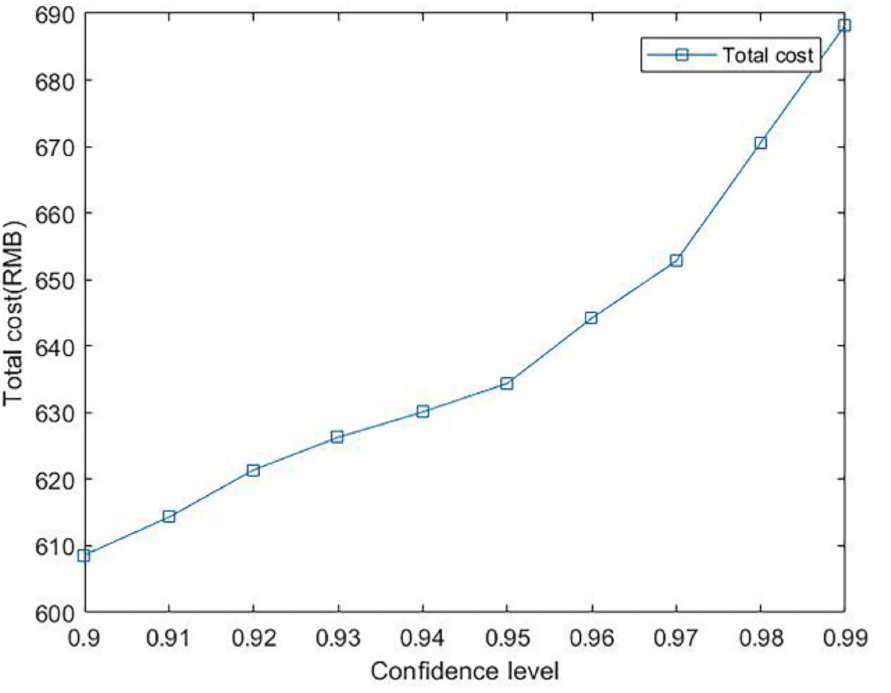
Figure 7. Operating cost curve under different confidence